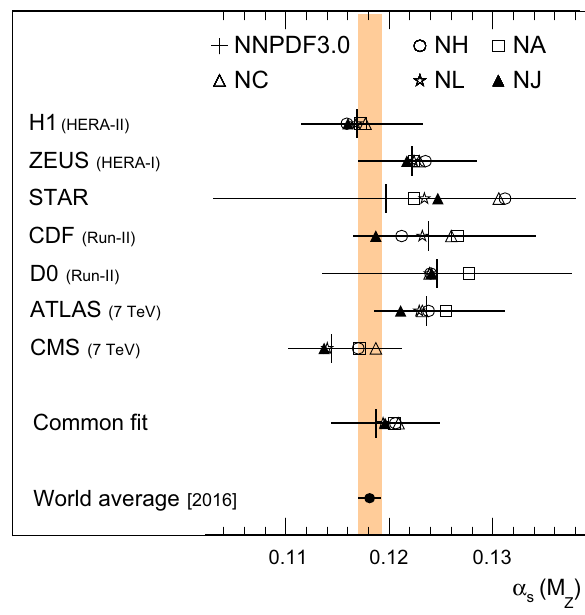
(NL), and NNPDF3.0_nojet (NJ). The values are compared to the value of α s ( M Z ) obtained with the NNPDF3.0 set and to the world average value [1]. The horizontal error bars, attached to the points representing the NNPDF3.0 results, indicate the total